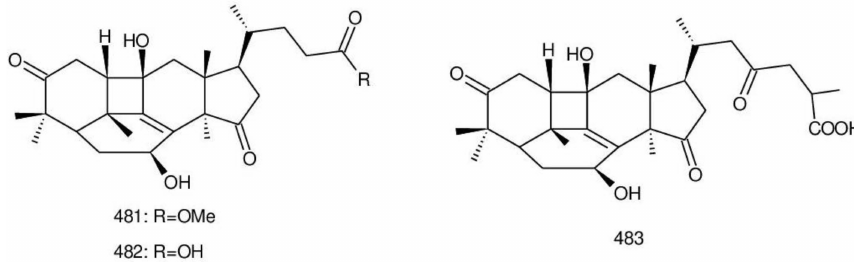
Figure 29. Chemical structures of several rearranged novel triterpenoids ( 481 – 483 ).